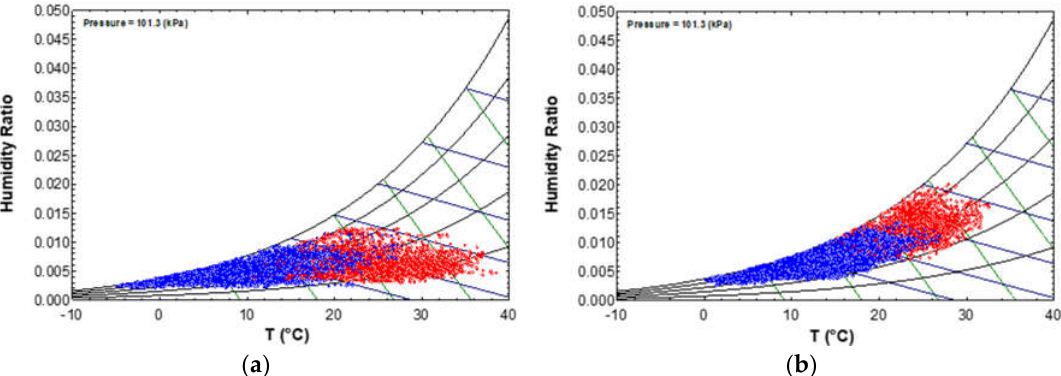
Figure 5. Weather conditions for (a) Madrid and (b) Barcelona.